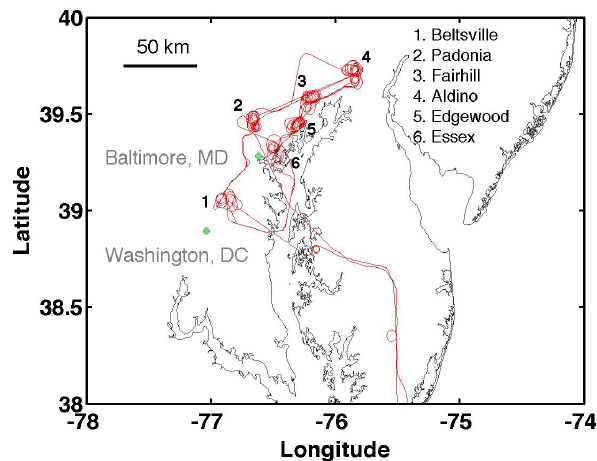
Fig. 1. Location of the DISCOVER-AQ field campaign no. 1 over Baltimore–Washington metropolitan area. The flight path followed by the P-3B is represented by the red line and the numbers corre- spond to the ground sites. Flight paths did not vary greatly between